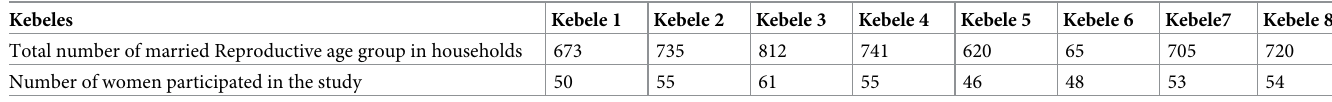
Table 1. Proportional allocation of study participants from each kebele in the Loma woreda, Dawuro Zone, Ethiopia 2020.